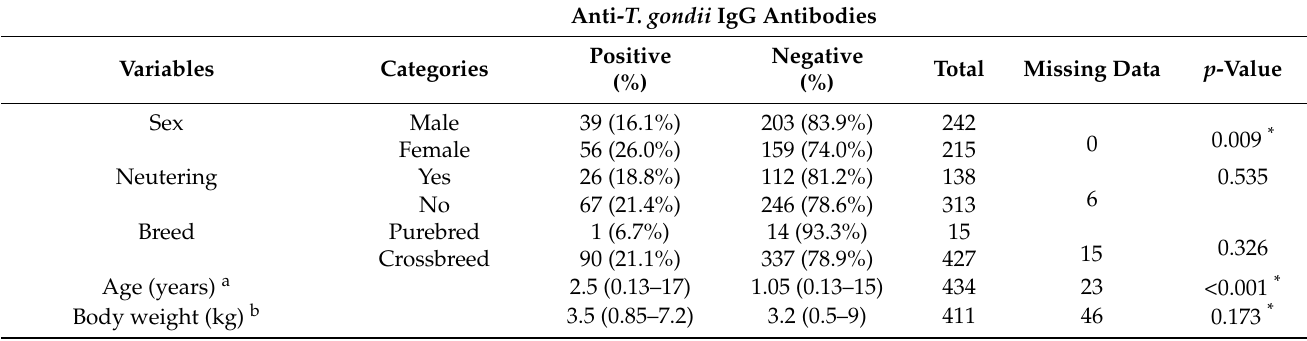
Table 1. Univariable associations between seropositivity for Toxoplasma gondii among 457 cats and the signalment and historical data that were collected using a standardized